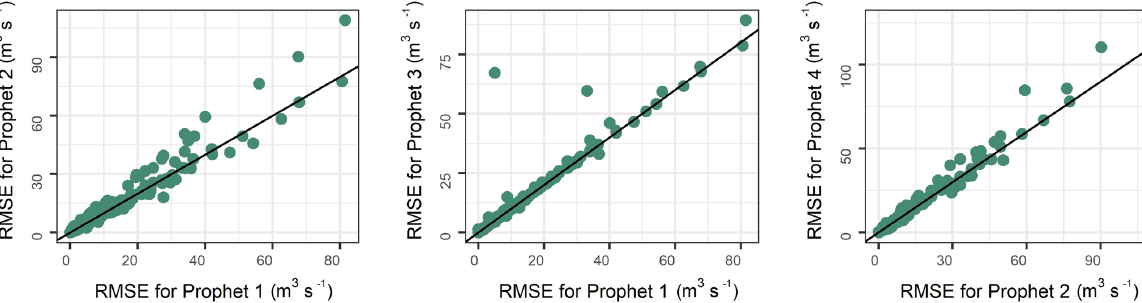
Figure 3. Comparison of the RMSE values for the 513 catchments as computed for three pairs of algorithms using the Prophet model. The RMSE values are presented in an aggregated